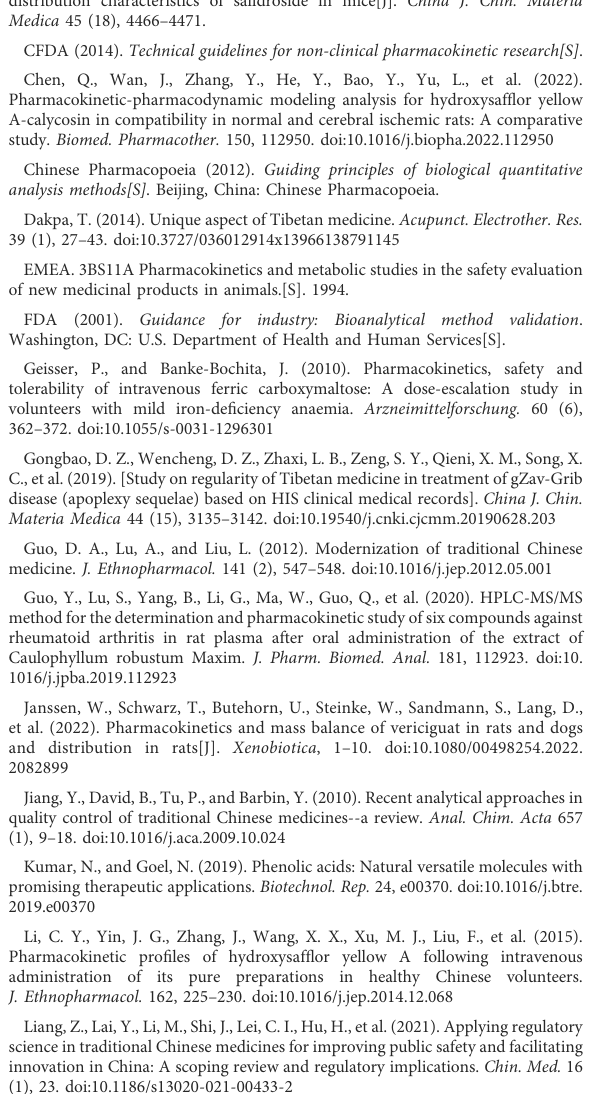
SUPPLEMENTARY FIGURE S5 Typical MRM chromatogram of piperine and internal standard in rat plasma by LC-MS/MS. I represents the analyte and II represents the internal standard. (A) Blank plasma in rats (double blank); (B) blank plasma with internal standard (blank); (C) real sample (single administration for 15.0 min); (D) quantitative lower limit sample. SUPPLEMENTARY FIGURE S6 Typical MRM chromatogram of ferulic acid and internal standard in rat plasma by LC-MS/MS. I represents the analyte and II represents the internal standard. (A) Blank plasma in rats (double blank); (B) blank plasma with internal standard (blank); (C) real sample (single administration for 15.0 min); (D) quantitative lower limit